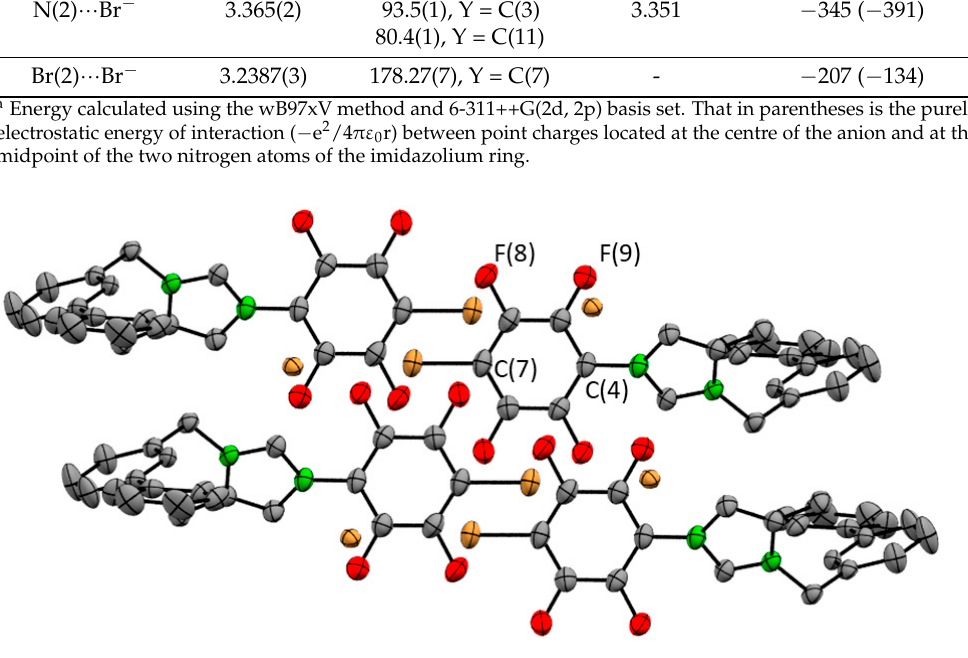
Figure 5. Packing of salt 3 viewed perpendicular to the planes of bromotetrafluorophenyl rings. Thermal ellipsoids were at the 50% level. Hydrogen atoms are omitted for clarity.